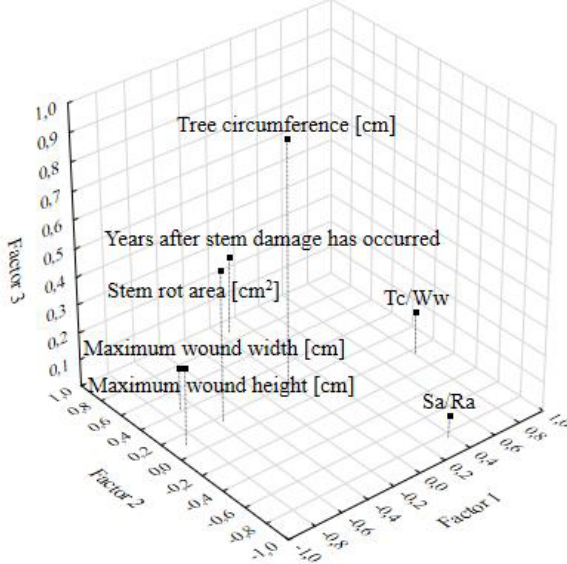
Figure 4. Diagram of factor loads.